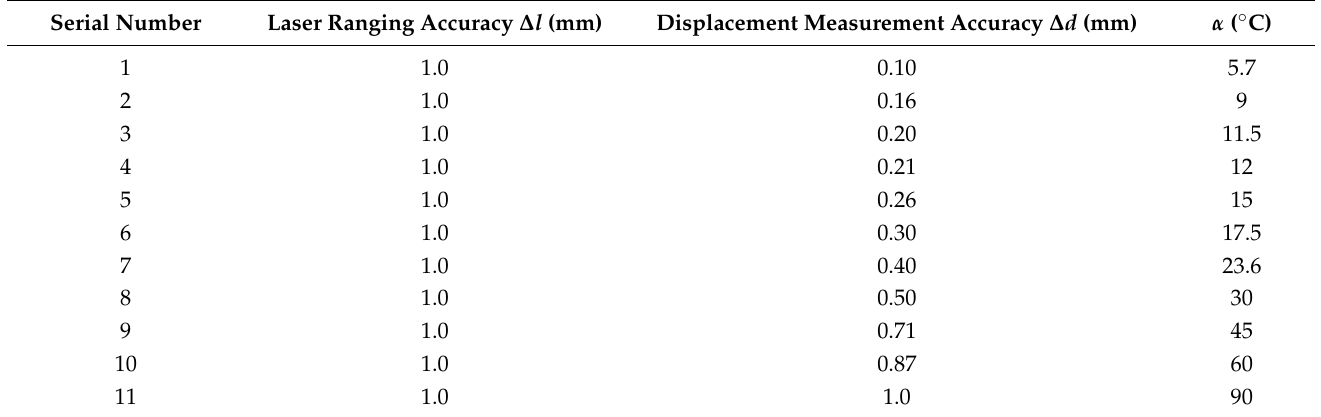
Table 7. Relationship between the theoretical deflection conversion accuracy and the laser emission angle α.